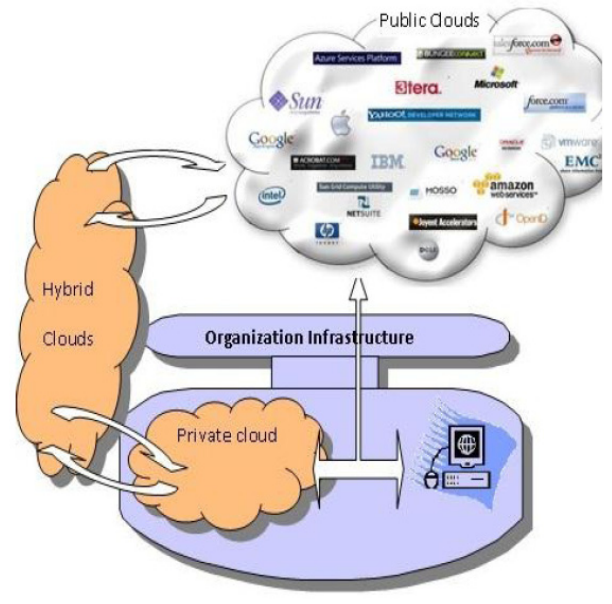
Figure 3. Cloud computing models [50].